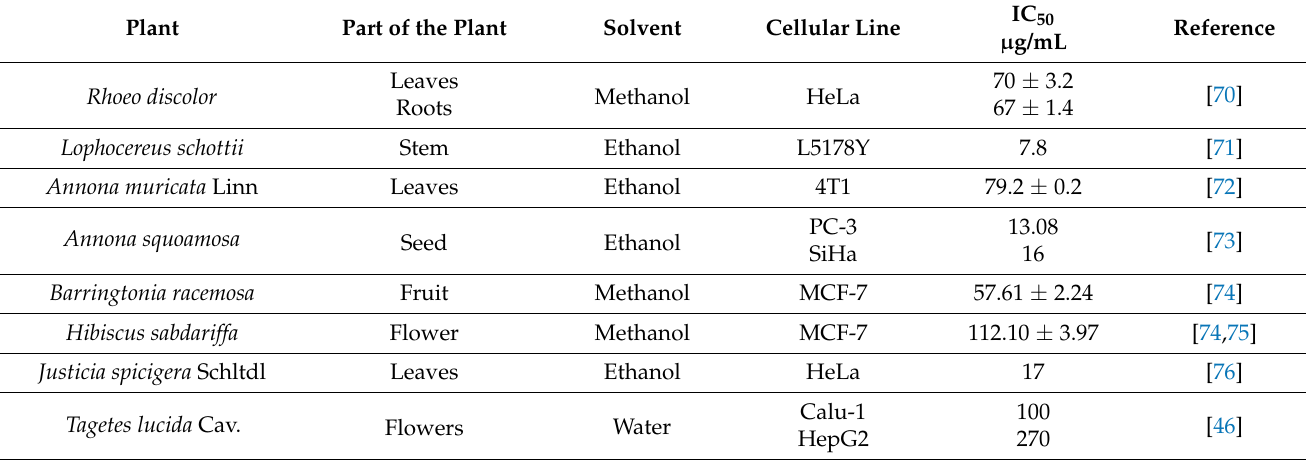
Table 2. Mexican medicinal plants with cytotoxic activity against different cell